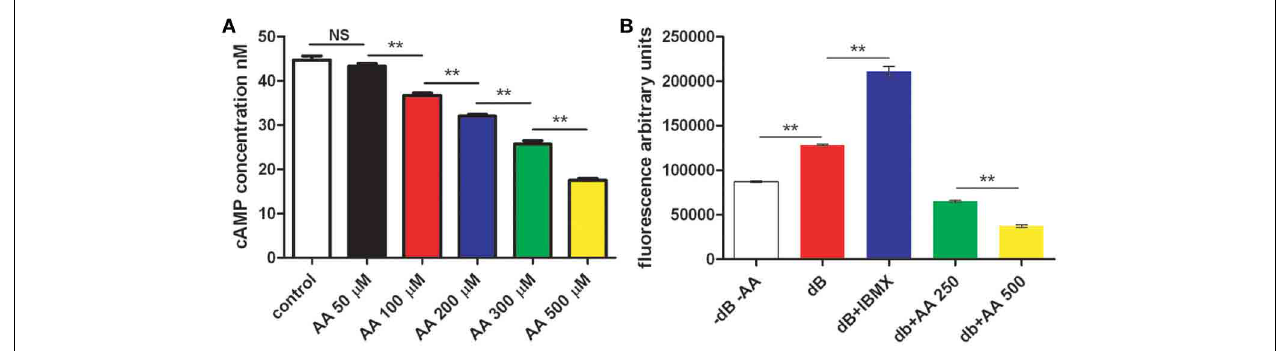
FIGURE 6 | cAMP, AA, and adipocyte differentiation. (A) 3T3L1 have been incubated without and with AA at increasing concentration. At the end cAMP concentration was evaluated as described (see Materials and Methods). (B) 3T3L1 cells were treated either with